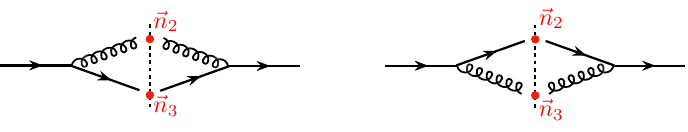
Figure 4. Feynman diagrams contributing to the leading order matching of the E ( ~n 2 ) E ( ~n 3 ) OPE onto the twist-2 quark operator O q